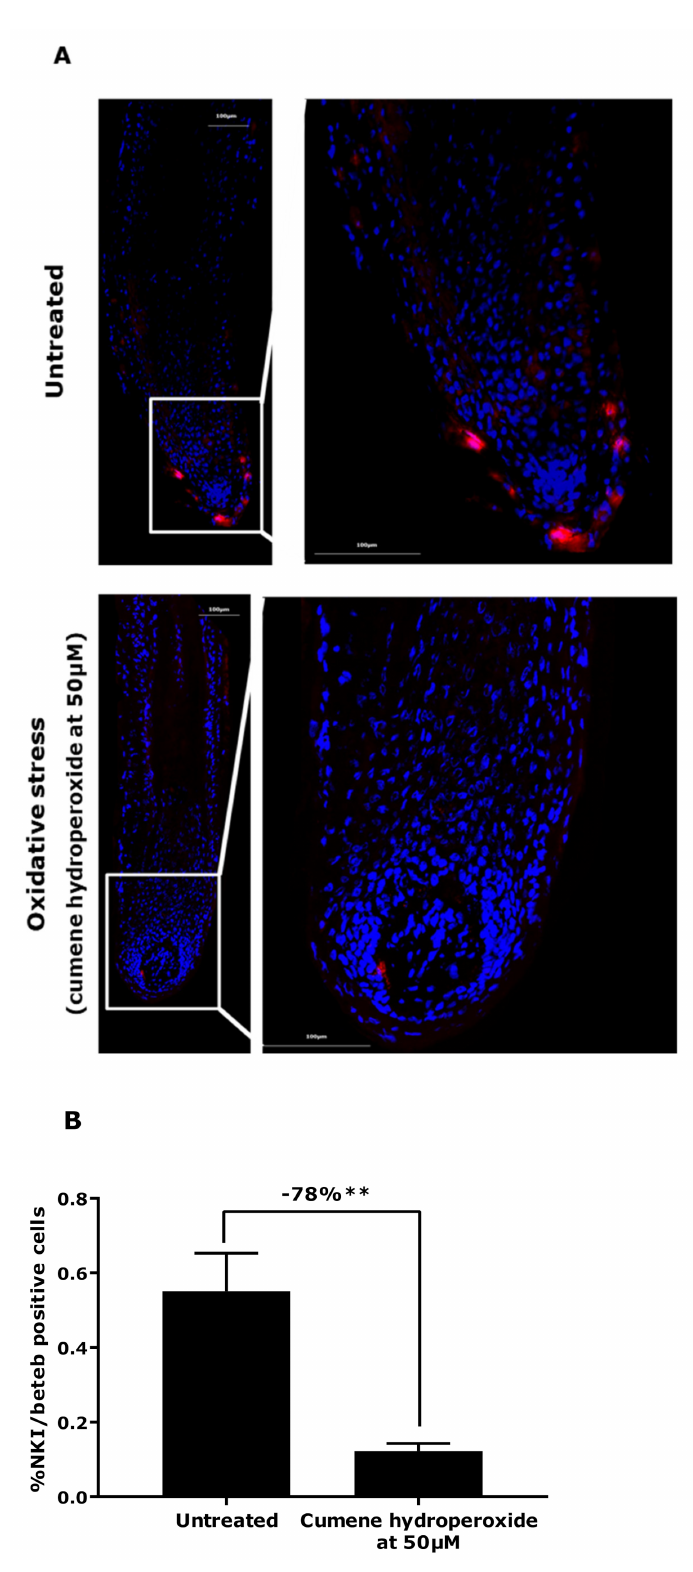
Figure 3. Melanocyte and melanoblast quantification by NKI/beteb immunofluorescence staining following oxidative stress (cumene hydroperoxide at 50 µ m) in hair follicles. ( A ) Representative images. Magnification: 10 × . ( B ) Data are presented as mean ± SEM. Statistical analysis was performed using one-way ANOVA with permutation test followed by a t -test with permutation, with ** p <